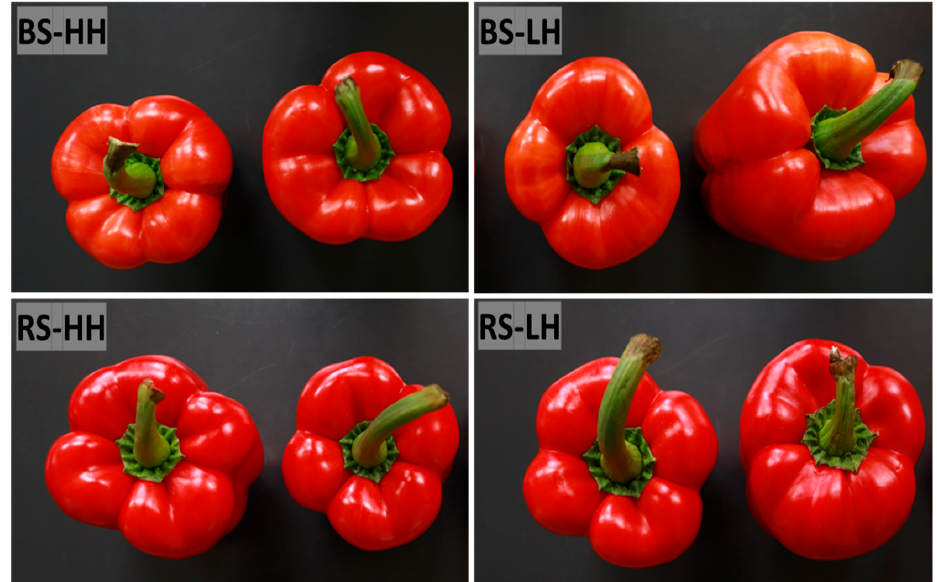
Figure 2. Fruit’s overhead image on the final day after 15 days of cold storage at 5 °C and 5 days at ambient conditions. HH means fruit kept in a humidified refrigerator, and LH means fruit kept in a regular refrigerator, while BS (breaker stage) and RS (red-ripe) represent maturity stages. Table 1. The effect of high and low RH on the soluble solids content and firmness of sweet peppers before and after 15 days of cold storage at 5 °C and 5 days at ambient conditions.